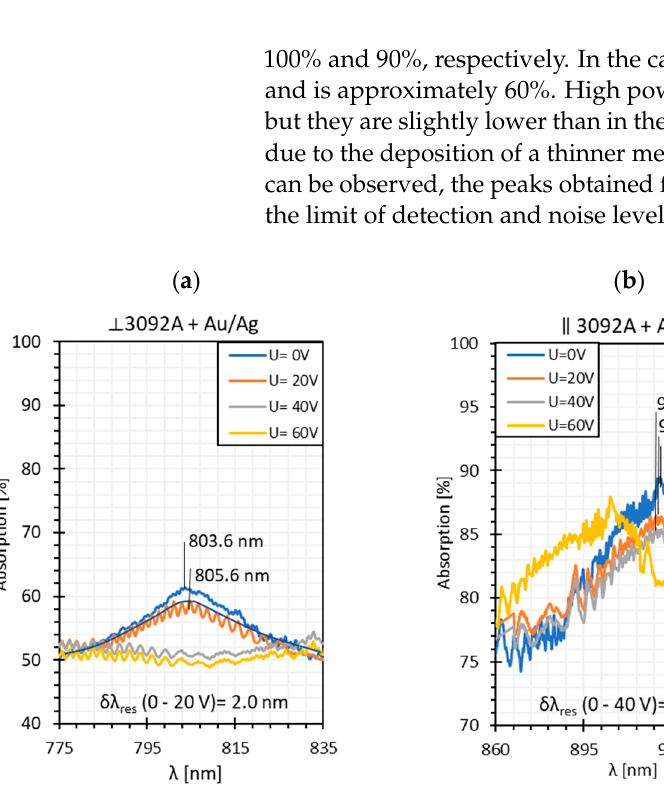
Figure 4. Absorption peaks obtained for ( a ) orthogonal, ( b ) parallel, and ( c ) twisted cells. The solid lines are the fitting curves obtained for absorption plots.